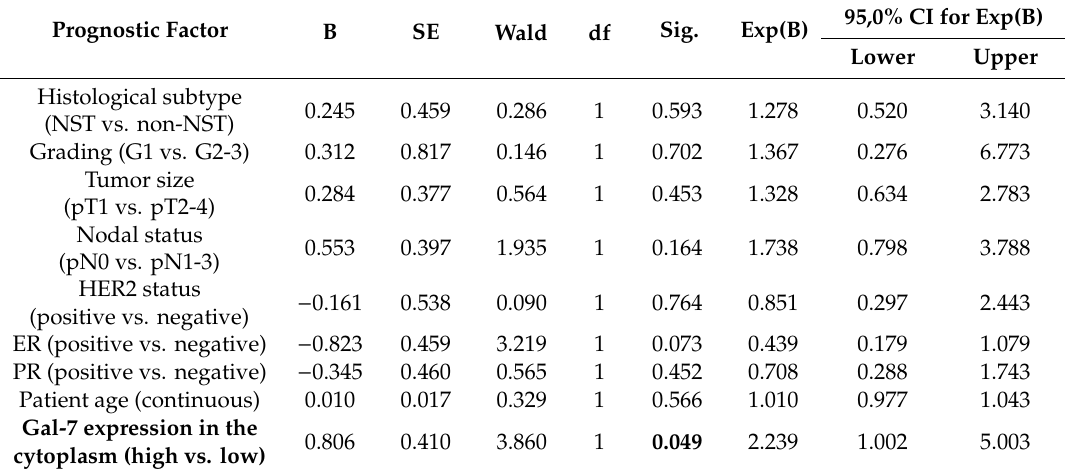
Table 4. Multivariate analysis of PFS concerning Gal 7 expression in the cytoplasm. Significant factors are highlighted in